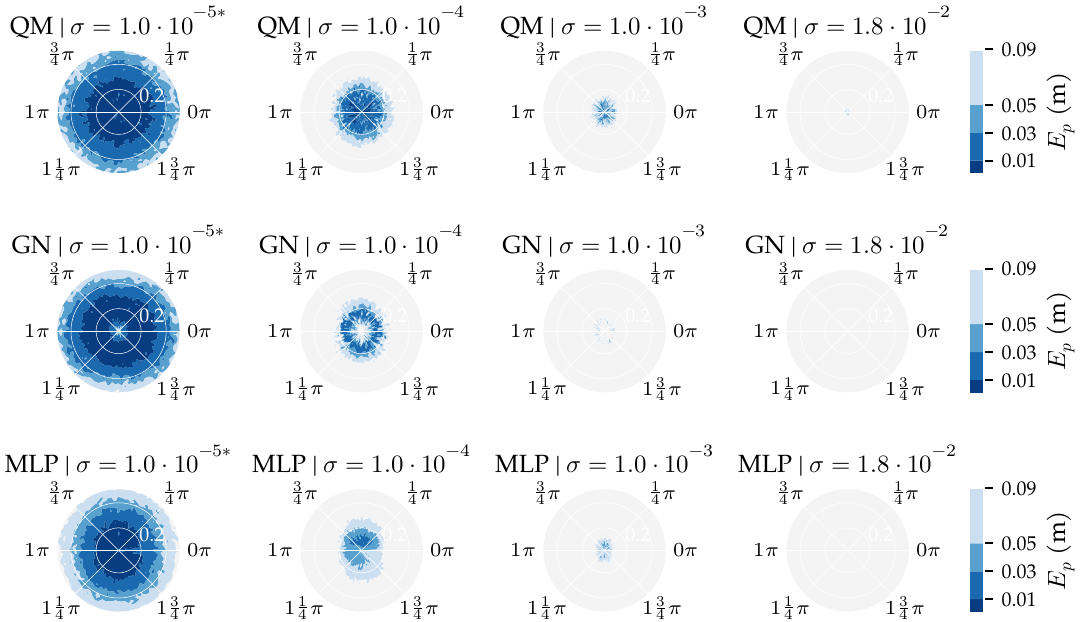
Figure A14. Spatial contours of the median movement direction error (Equation (5)) for QM, GN, and MLP using simulated sensors with higher velocity equivalent noise levels. The D s = 0.01 training and optimisation set and (x + y) sensor configuration were used. The values for σ = 1.0 × 10 − 5 ms − 1 are based on the D s = 0.01 condition in Analysis Method 1. The MLP was re-trained for each noise level. Both the MLP and GN used the optimal hyperparameter values from the D s = 0.01 condition of Analysis Method 1. The median movement direction error was computed in 2 × 2 cm 2 cells. The sensors were equidistantly placed between x = ± 0.2 m.